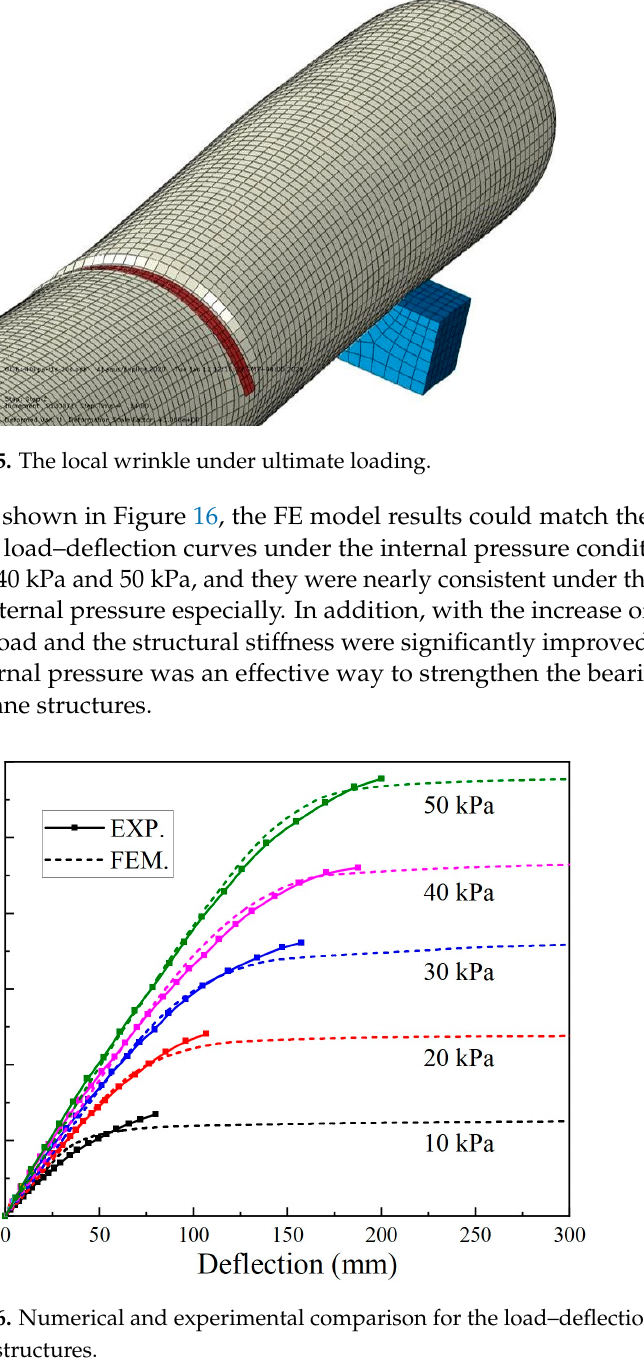
Figure 16. Numerical and experimental comparison for the load–deflection response of midspan of inflated structures.